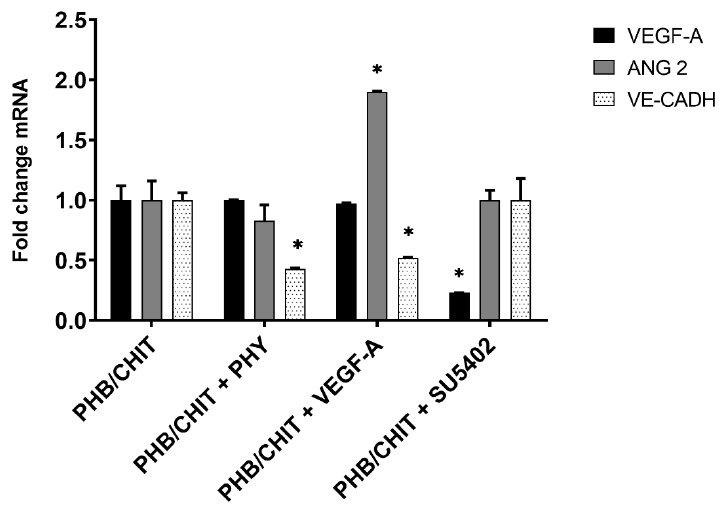
Figure 10. Relative gene expressions from RT-qPCR analysis for genes VEGF-A, ANG-2, and VE- CADH (* statistically significant difference; * p < 0.0001). Experiments were repeated three times (biological replicates: 5 samples for each group, technical replicates: 15 for each group). * p <